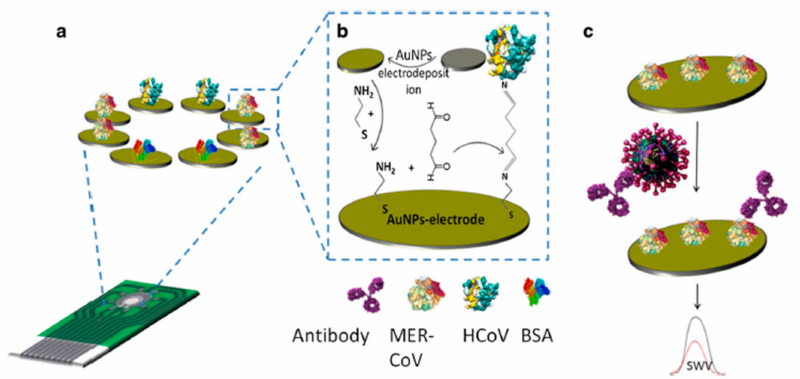
Figure 7. ( a ) An immunosensor for MERS-CoV detection; ( b ) fabrication of the biosensor and its surface functionalization; ( c ) virus detection process